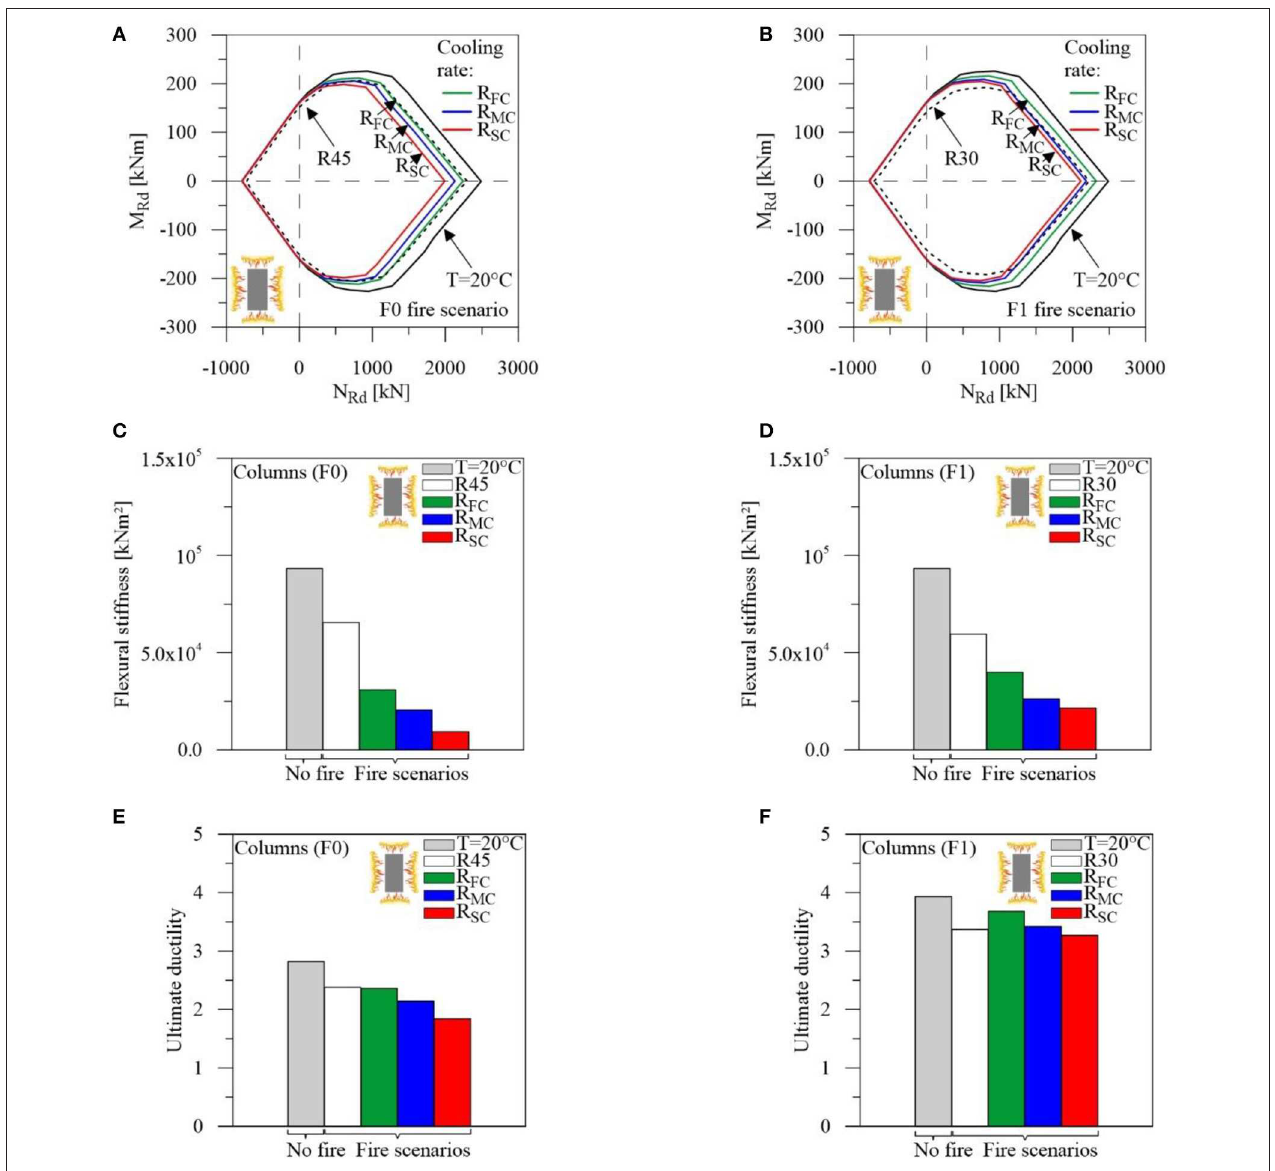
FIGURE 8 | Residual properties for interior columns of the Collina-Castello school: F0 (A,C,E) and F1 (B,D,F) fire scenarios.